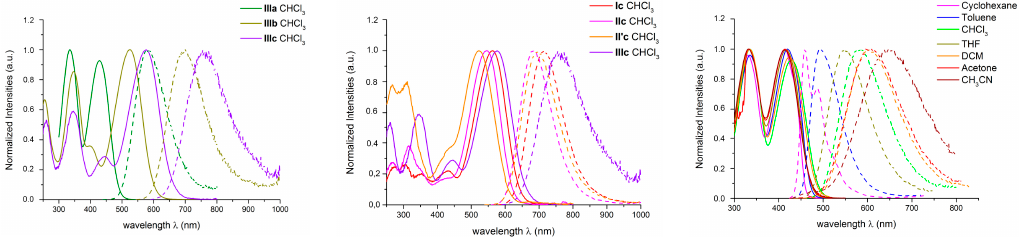
Figure 1. ( left ) Absorption (solid line) and emission (dashed line) spectra of derivatives of series IIIa – c in CHCl 3 ; ( middle ) Absorption and emission spectra of derivatives I – IIIc in CHCl 3 ; ( right ) Solvatochromic behavior of dye IIIa in organic solvents of increasing polarities.